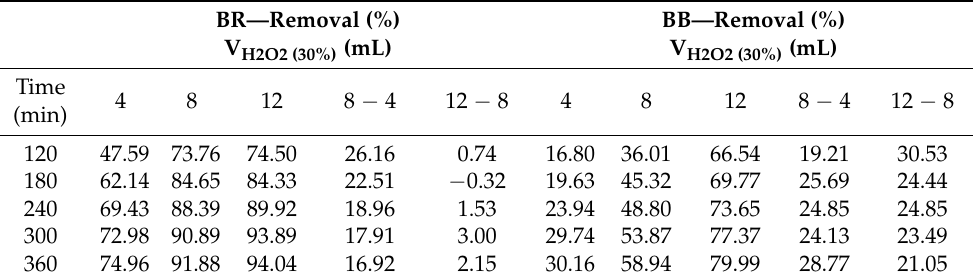
Table 7. The influence of oxygen peroxide volume on dye